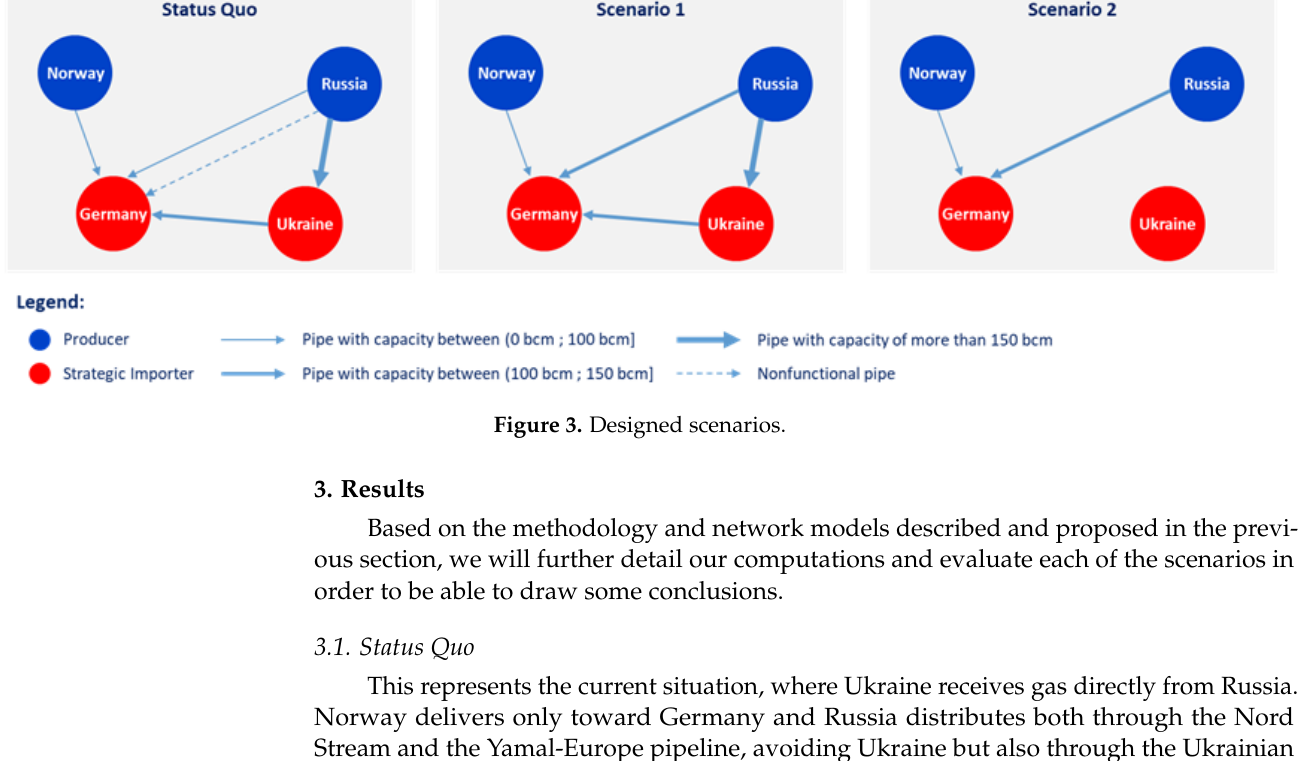
Table 2. Specifications and computation results related to links.